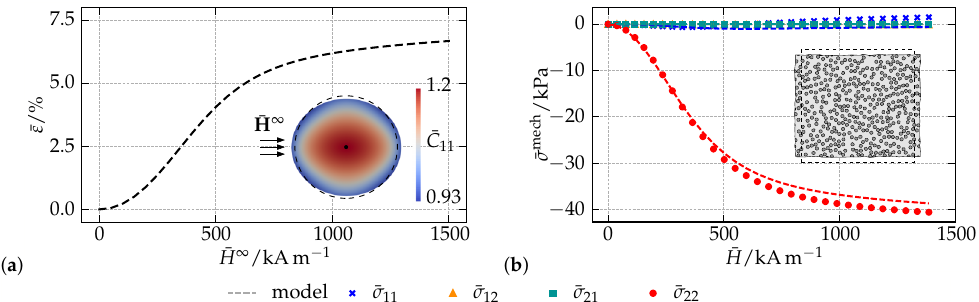
Figure 5. Magneto-deformation of a circular MAE sample with φ = 30% particle-volume fraction: ( a ) predicted magnetically induced deformation of the sample and contour plot of the macroscopic deformation field, and ( b ) comparison of the calibrated macro- and averaged micro-contnuum models regarding their predictions for the macroscopic mechanical stress at the center of the sample. Data taken from